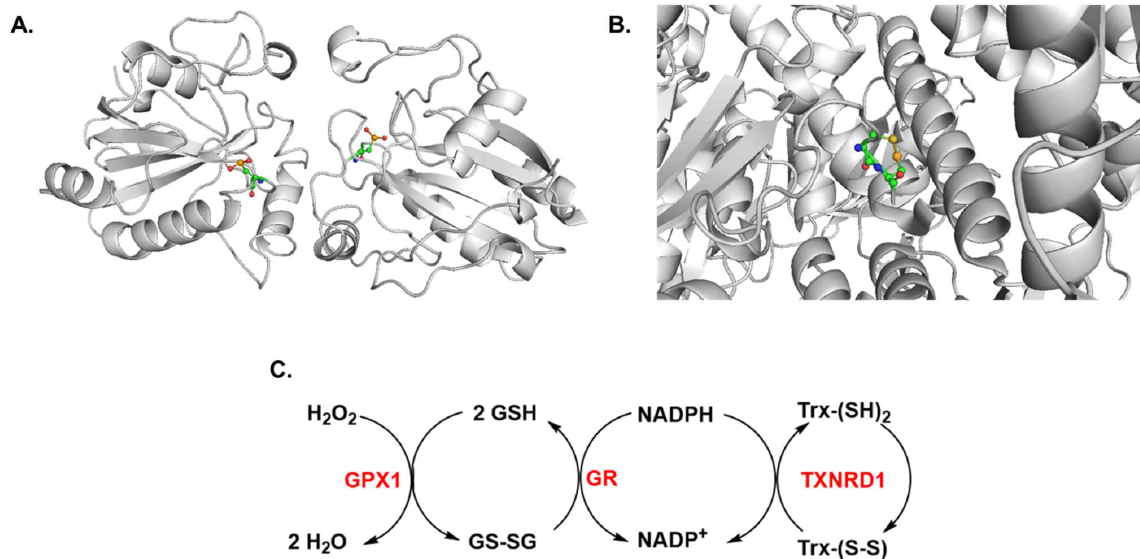
Figure 1. Selenium is required to ensure the expression and functionality of selenoproteins to protect cells from oxidative damage. ( A ) Structure of selenoenzyme glutathione peroxidase GPX1 in Bos taurus (Bovine), which plays an essential role in detoxifying hydrogen peroxide (PDB: 1GP1). Selenium is a crucial intracellular part of this enzyme’s ability to protect cells. ( B ) Crystal structure of recombinant rat thioredoxin reductase TXNRD1 with oxidized C-terminal tail depicting the selenocysteine residue that is key for its catalytic activity (PDB: 3EAO). The functionally important selenocysteine residue present in the active site of ( A ) and ( B ) is highlighted in color. ( C ) Scavenging of ROS by GPX1 and catalytic redox cycle of selenoprotein thioredoxin (Trx) by Trx reductase TXNRD1 . GR, glutathione reductase; GSH, glutathione (reduced form); GSSG, glutathione disulfide.